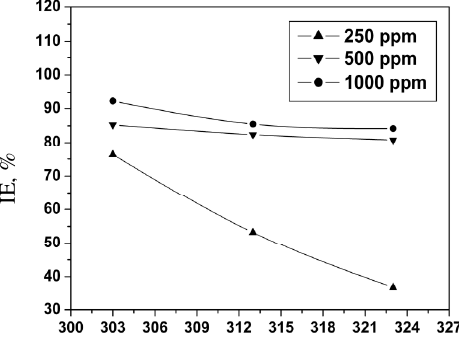
Figure 2. Variation of inhibition efficiency as a function of temperature for various inhibitor concentrations in 1 N H